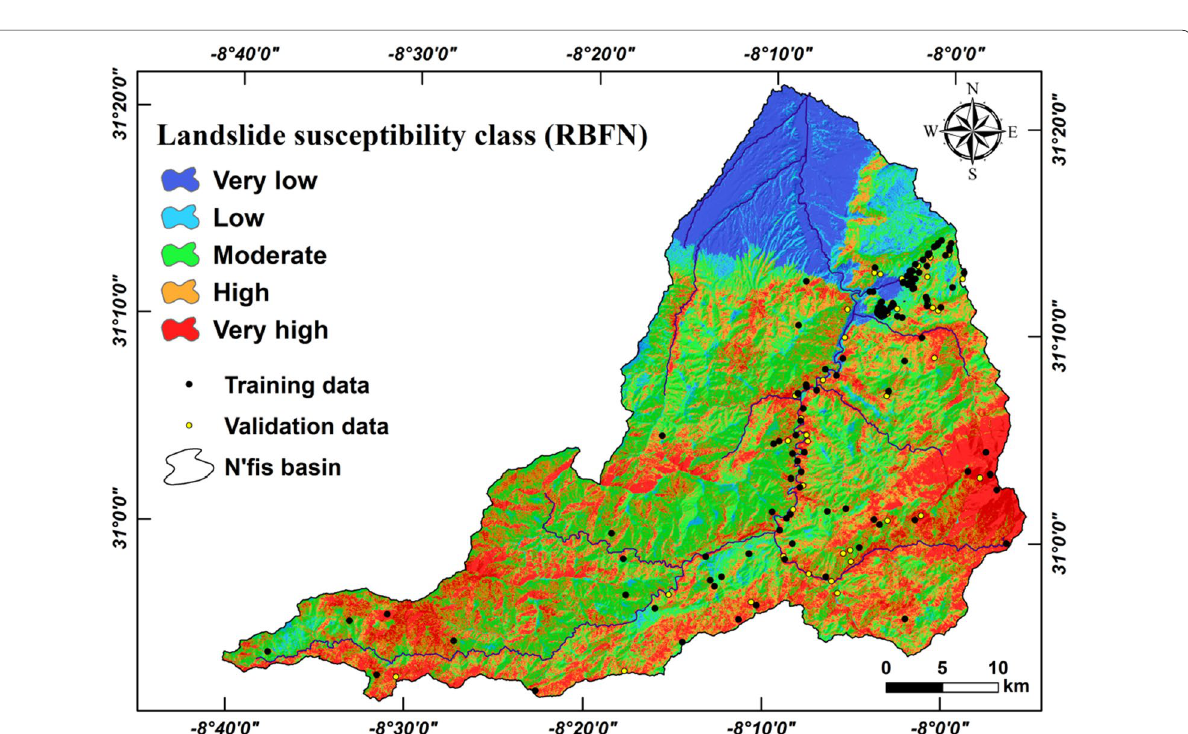
Fig. 8 Landslide susceptibility map using RBFN